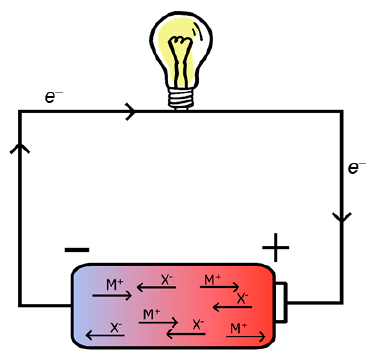
Figure 1. Drawing of a traditional battery and the flow of electrons (e − ), cations (M + ) and anions (X). In a lithium-ion battery, the anode consists of a carbon material (commonly graphite) with lithium stored between the carbon layers [2]. These layers stabilize the lithium in a high energy metallic state.